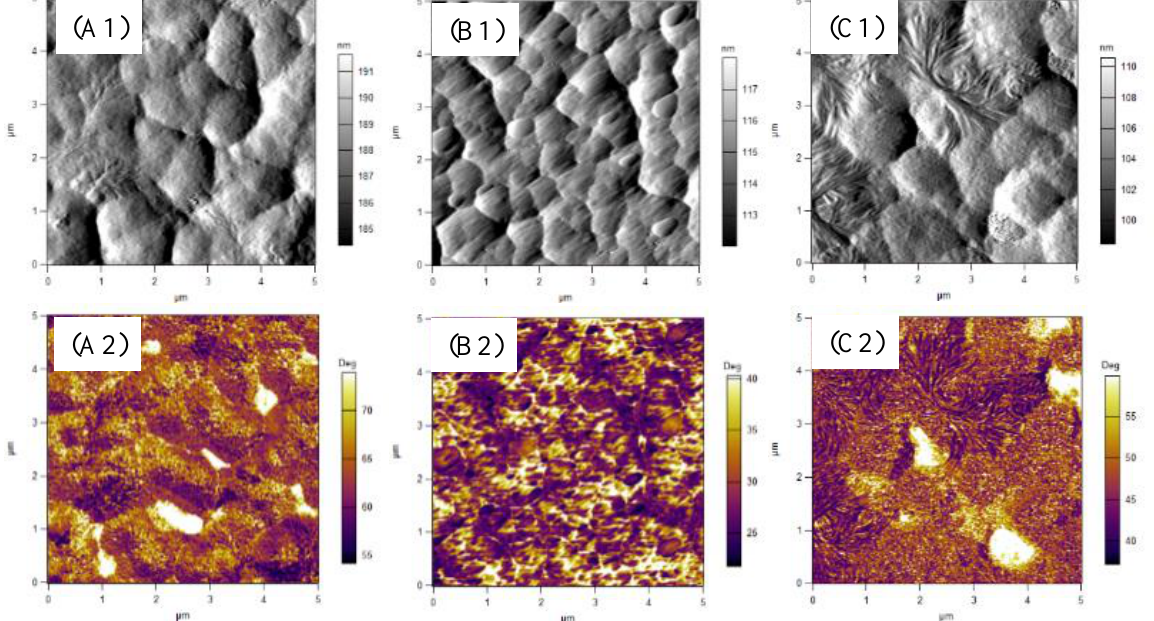
Figure 9. AFM ( 1 ) amplitude and ( 2 ) phase images of dried PVDF/DMF/acetone solution droplets with various concentrations. ( A ) 10 mg/mL, ( B ) 12 mg/mL, ( C ) 20 mg/mL.